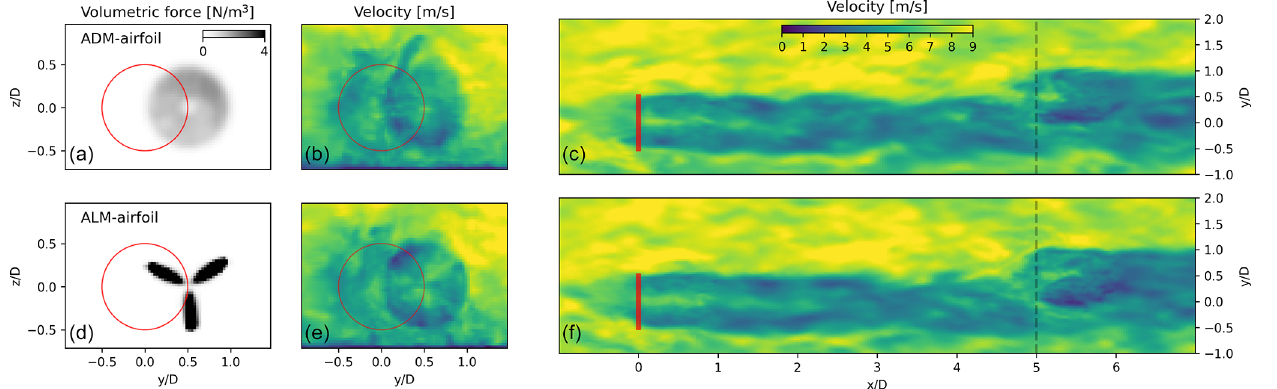
Figure 9. Model comparison for two turbines in an ABL under horizontally averaged velocity inflow conditions at hub height of U ∞ = 8ms − 1 : instantaneous force (a, d) and velocity (b, e) in a vertical plane at the WT2 location. The WT1 rotor position is indicated with a red circle. (c, f) Instantaneous velocity in a horizontal plane position at hub height, with the WT2 vertical plane marked with a dashed line.